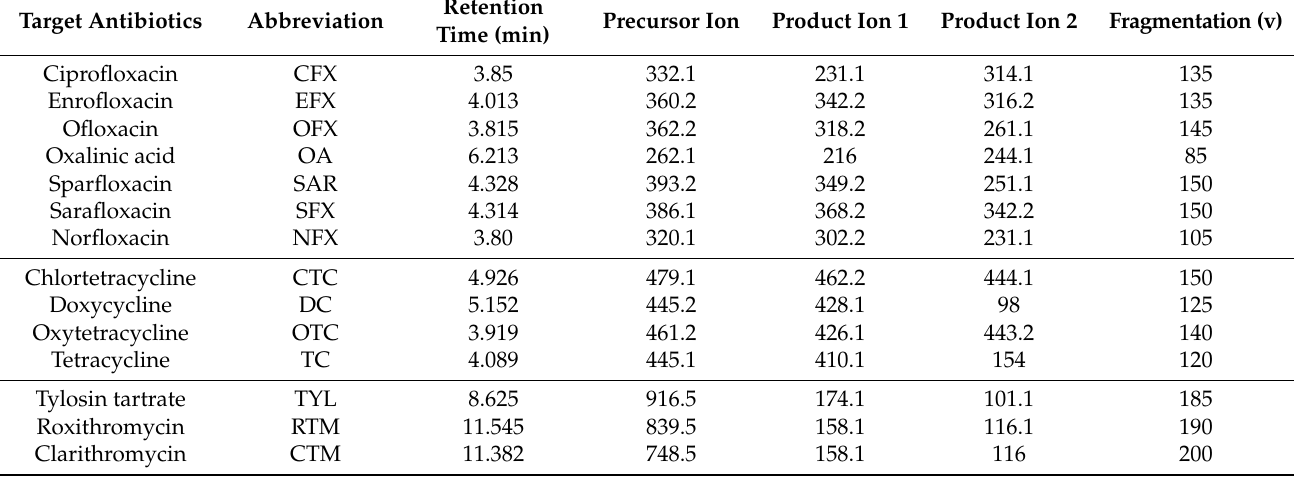
Table A1. Optimized LC-MS/MS parameters including retention time, precursor, product ions, and